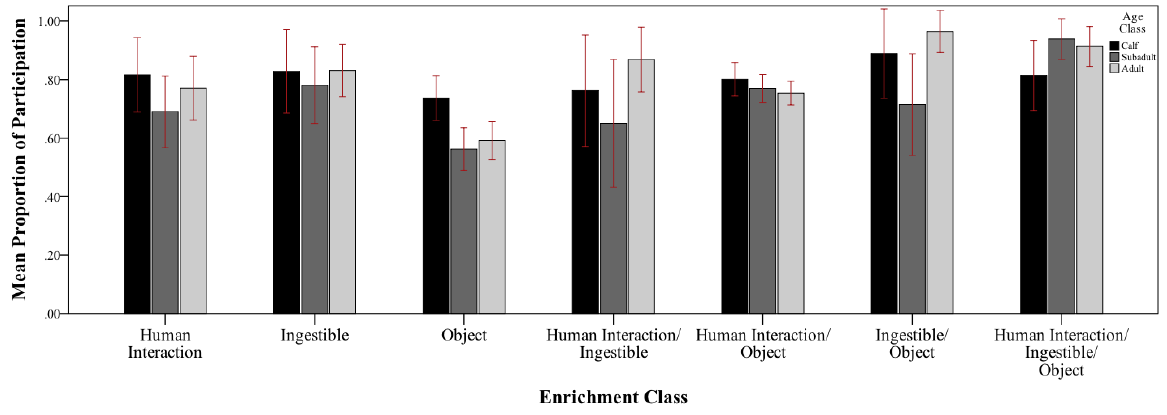
Figure 5. Mean (±2SE) proportion of calves ( n = 5), sub-adults ( n = 6), and adults ( n = 8) that participated with each enrichment class, including all trials and subjects.